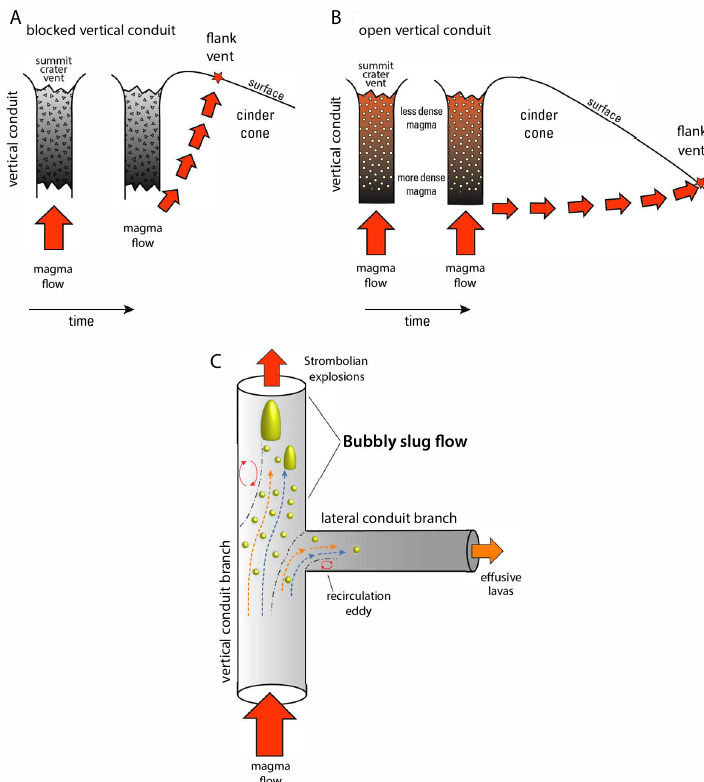
Figure 4: Conceptual models of shallow magma flow at Veniaminof Volcano. [A] Up- ward flow of magma encounters plugged, lava-filled